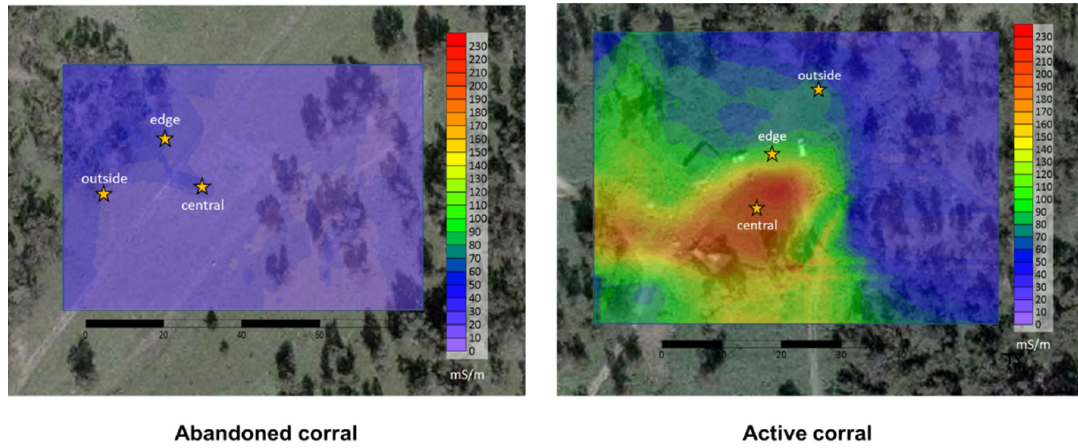
Figure 5. Orto-photo map and electrical conductivity (EC) measurements by FDEM showing leakage in an abandoned ( left ) and active ( right ) corral at the Plugot forest site.